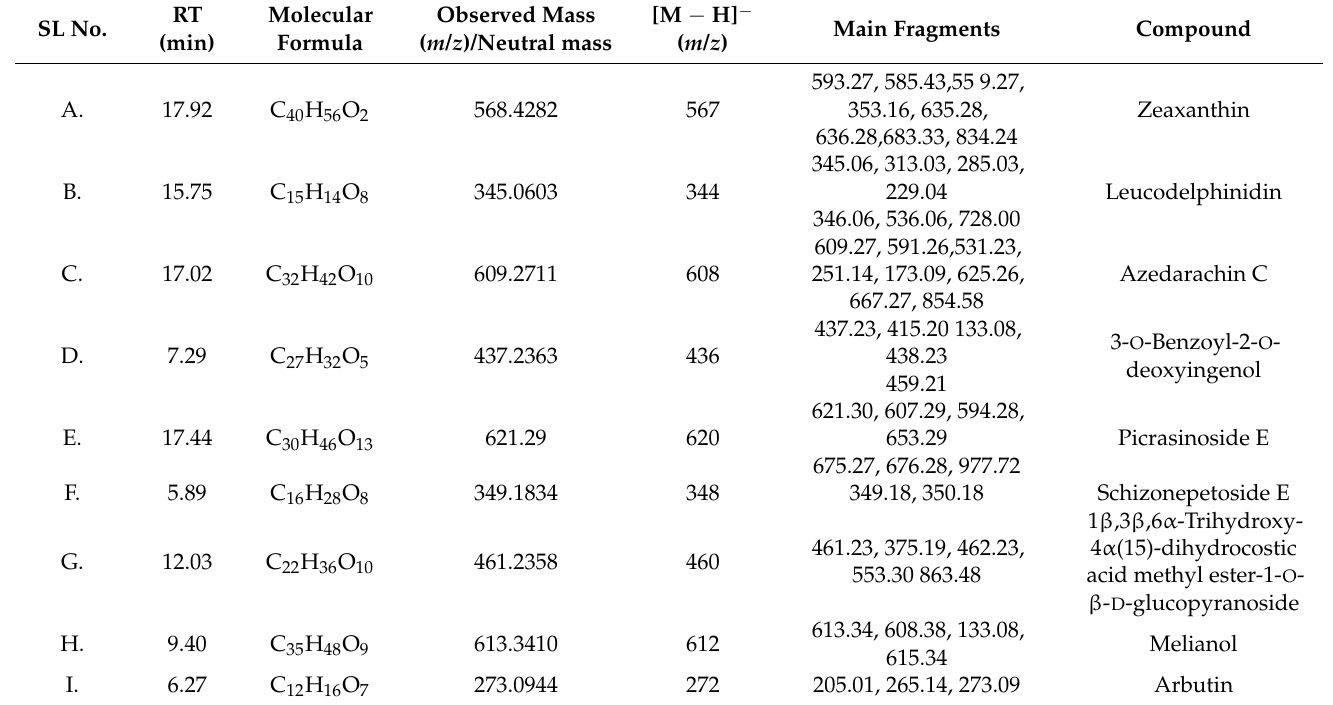
Table 2. Tentatively identified compounds of